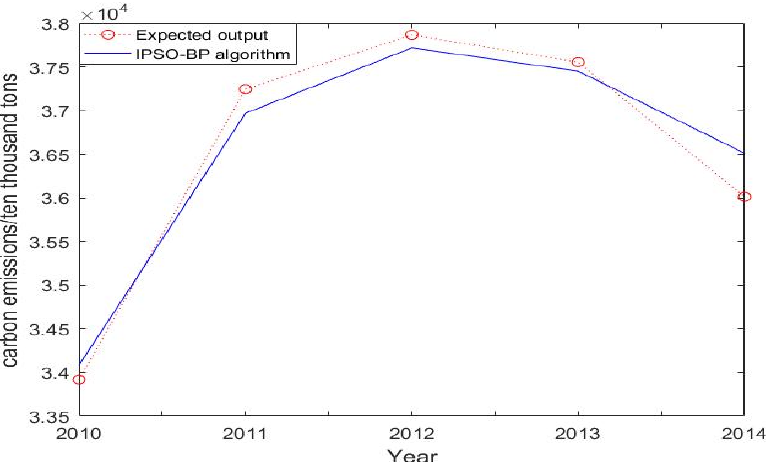
Figure 4. The result of CO 2 emission of expect output and the inspection results of the improved particle swarm optimization-back propagation (IPSO-BP) neural network during the period of 2010–2014. Figure source: This paper selected the data of carbon emissions from energy consumption in Beijing-Tianjin-Hebei region during the period of 1994–2009 as training samples, and the remaining data during the period of 2010–2014 as test samples, and obtained inspection results of the IPSO-BP neural